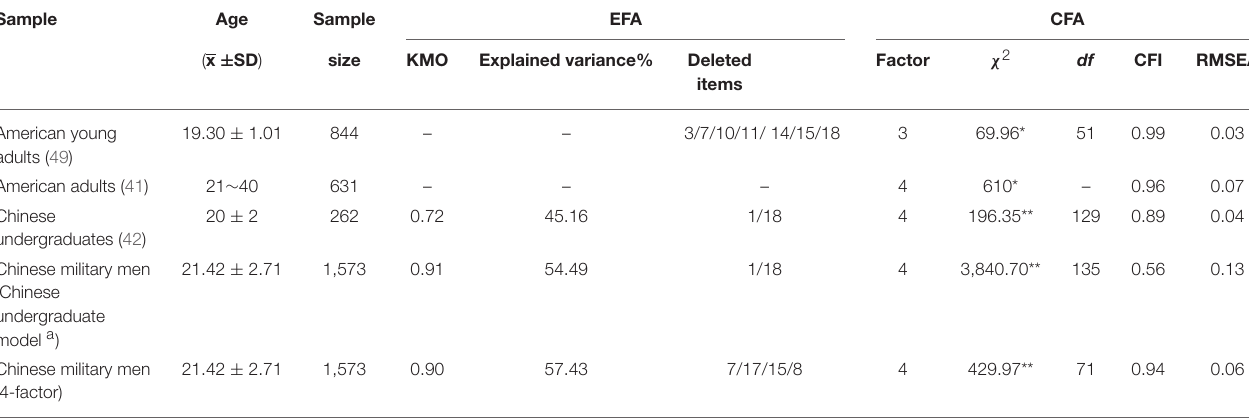
TABLE 4 | Summary of factor analyses for versions of revised Behavioral Activation/Inhibition scales.